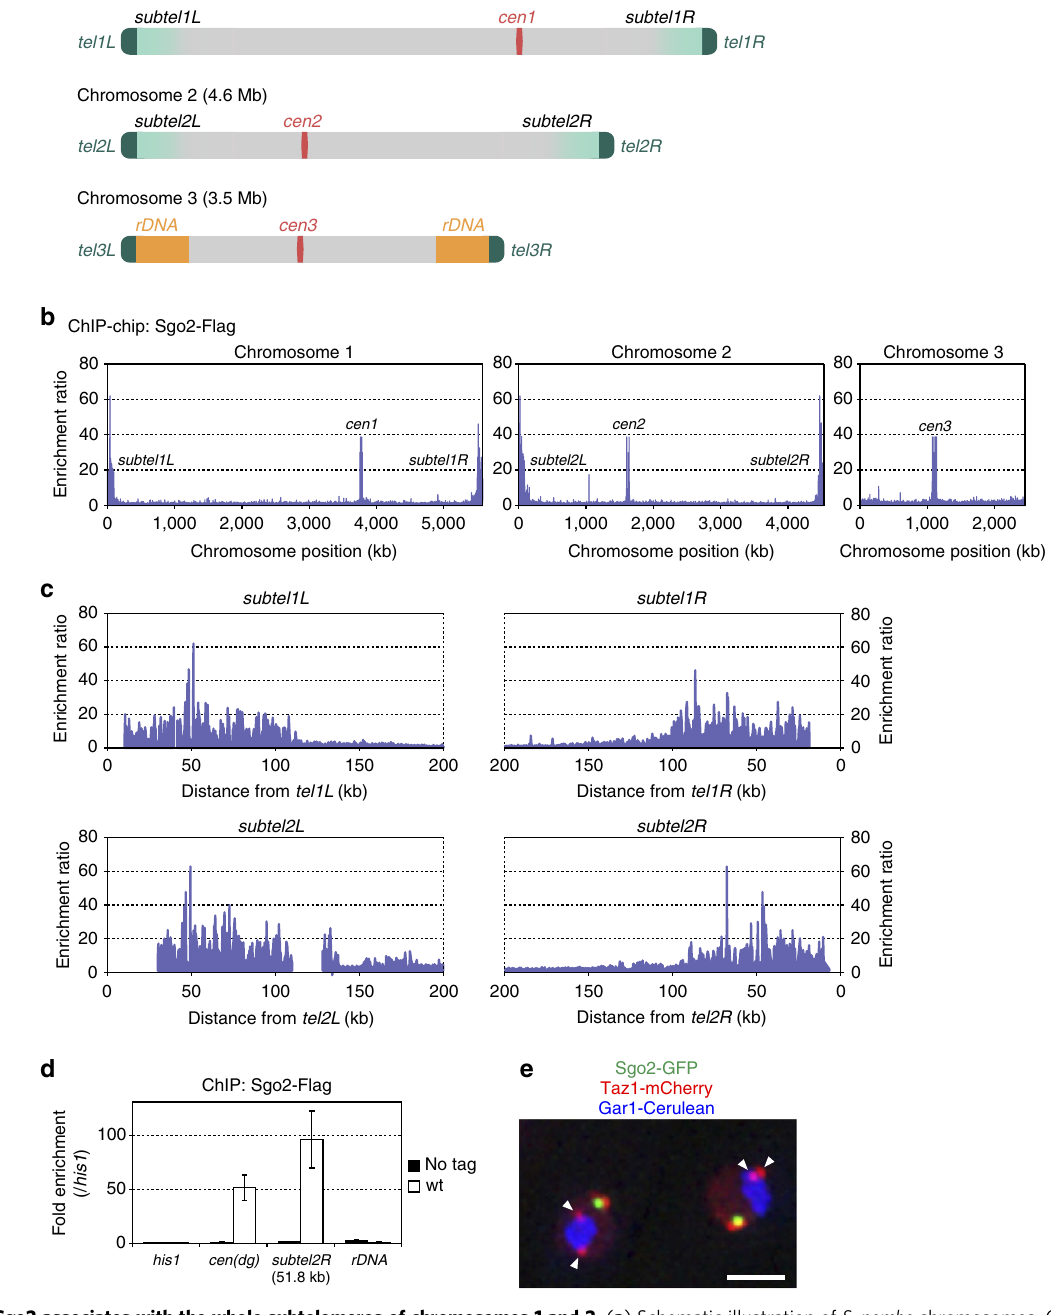
Figure 1 | Sgo2 associates with the whole subtelomeres of chromosomes 1 and 2. ( a ) Schematic illustration of S. pombe chromosomes. Chromosomes 1 and 2 contain telomere-proximal common sequences that are highly similar among the subtelomeres, whereas chromosome 3 contains rDNA repeats close to the telomeres. ( b ) ChIP–chip analysis of the genome-wide distribution of Sgo2-Flag in logarithmically growing wt cells. It is noteworthy that the probes used in the tiling array did not encompass regions outside the rDNA repeats on chromosome 3. ( c ) Magnification of the ChIP–chip data for the subtelomeric regions shown in b . Gaps in the data represent regions not included in the chips due to a lack of sequence information. ( d ) ChIP analyses of Sgo2-Flag localization at the rDNA repeats in asynchronous cultures (predominantly in interphase). Relative fold enrichment, normalized to the signal at the his1 þ locus, is shown. No tag indicates the negative control for the ChIP analyses; cen(dg) indicates the dg repeats at the centromeres; subtel2R-51.8K indicates 51.8kb from tel2R . Error bars indicate the s.d. ( n ¼ 3). ( e ) Subnuclear localization of Sgo2-GFP. Sgo2-GFP, Taz1-mCherry (telomere) and Gar1-Cerulean (nucleolus) signals are shown in green, red and blue, respectively. Arrowheads indicate the telomeres of chromosome 3. Scale bar, 2 m